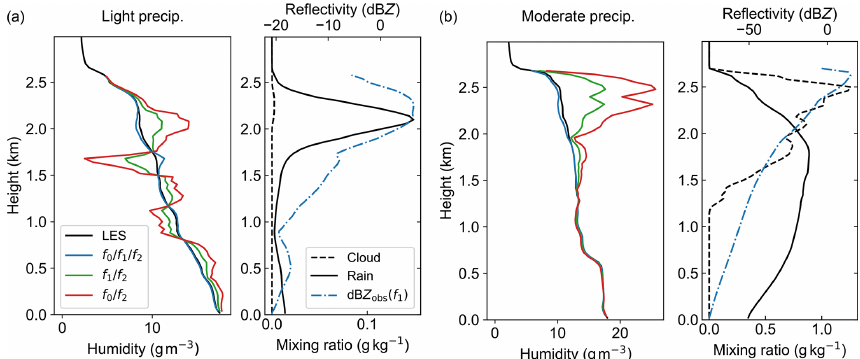
Figure 1. Comparison of two-frequency and three-frequency DAR humidity retrievals (see Sect. 2.3) using atmospheric profiles from the RICO LES. An ideal reflectivity measurement is assumed, with no multiple scattering, arbitrarily high range resolution and measurement sensitivity, and zero random measurement error. Retrievals are performed using a differential absorption baseline equal to the model vertical resolution of r + − r − = 40m. (a) Humidity retrievals vs. LES truth (left subpanel) for a lightly precipitating grid cell; (right subpanel) Liquid water mixing ratio profiles and corresponding observed reflectivity at f 1 = 168GHz. (b) Same as panel (a) but for a moderate precipitation case. In both cases, performing the three-parameter fit using the model function in Eq. (6) removes the humidity biases that originate from frequency dependence of hydrometeor backscatter and